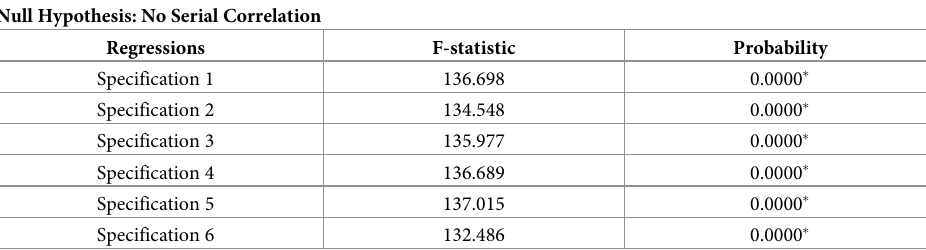
Table 7. Wooldridge test for serial correlation (indirect